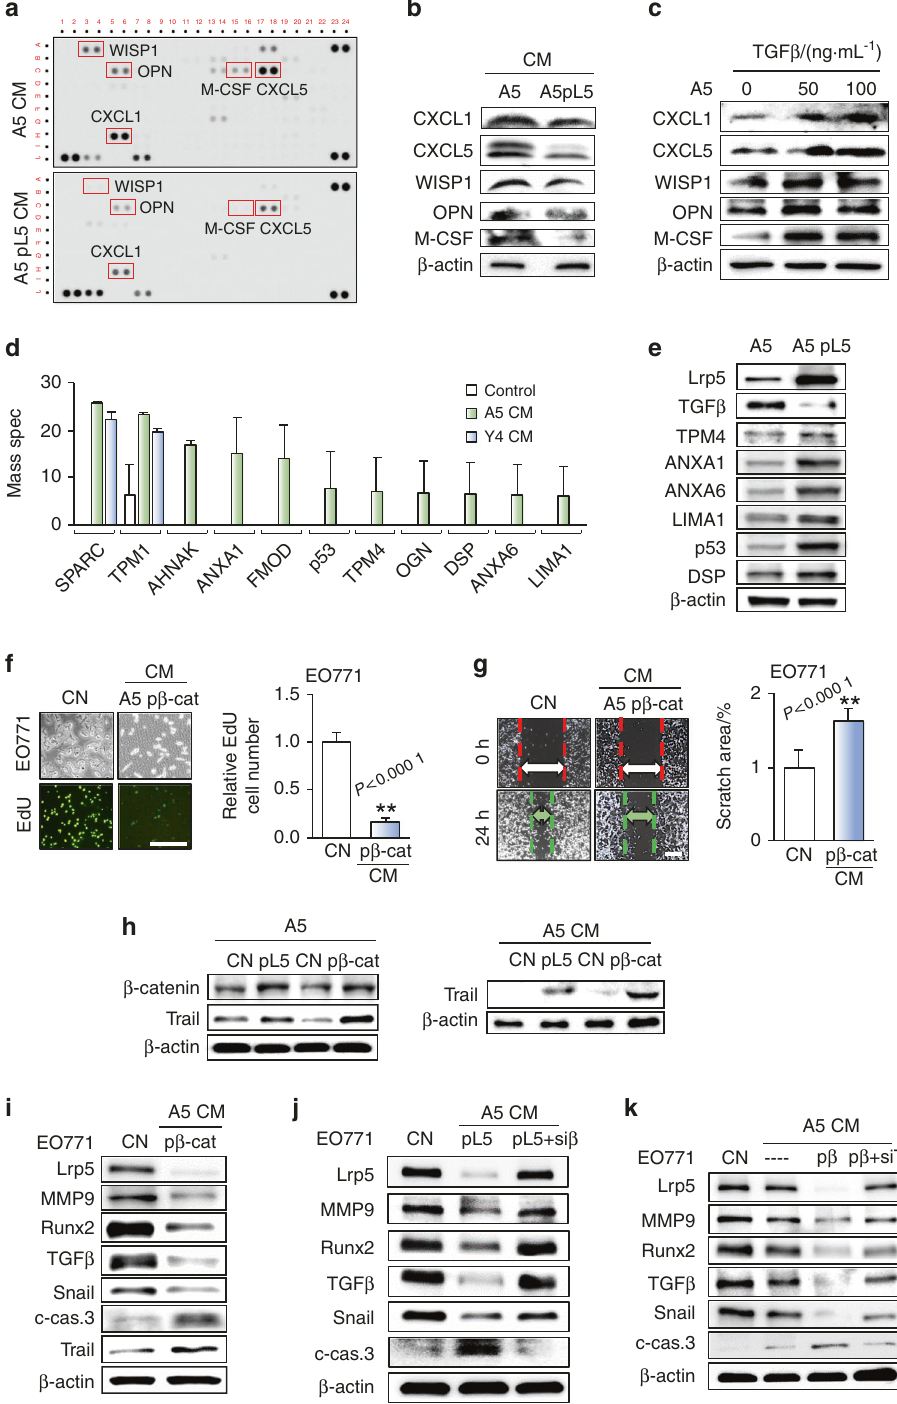
Fig. 5 Regulation of tumor-promoting and tumor suppressor genes by A5 osteoblasts. CN control (plain medium), CM conditioned medium, pL5 Lrp5 plasmids, p β -cat β -catenin plasmids, si β β -catenin siRNA, and siT Trail siRNA. a Comparison of the expression levels of 111 cytokines in CM from parental A5 cells and CM from Lrp5-overexpressing A5 cells. The levels of CXCL1 and CXCL5 were decreased in CM from Lrp5-overexpressing osteocytes. b Expression of CXCL1, CXCL5, WISP1, OPN, and M-CSF in A5 osteocytes with and without Lrp5 overexpression. c Elevation of CXCL1, CXCL5, WISP1, OPN, and M-CSF by TGF β . d Proteins enriched in A5 osteocyte-derived CM. e Expression of TGF β , TPM4, ANXA1, ANXA6, LIMA1, p53, and DSP in A5 osteocytes with and without Lrp5 overexpression. f , g Signi fi cant reductions in the proliferation and migration of EO771 cells after treatment for 48h with β -catenin-overexpressing osteocyte-derived CM. Scale bar: 200 μ m. h Elevation of β -catenin and Trail by overexpression of Lrp5 and β -catenin in A5 osteocytes and in their conditioned medium. i Protein levels of Lrp5, MMP9, Runx2, TGF β , Snail, cleaved caspase 3, and Trail in EO771 cells in response to β -catenin-overexpressing osteocyte-derived CM. j Suppression of the inhibitory effects of Lrp5-overexpressing osteocyte-derived CM by silencing of β -catenin. k Suppression of the inhibitory effects of β -catenin-overexpressing osteocyte- derived CM by silencing of